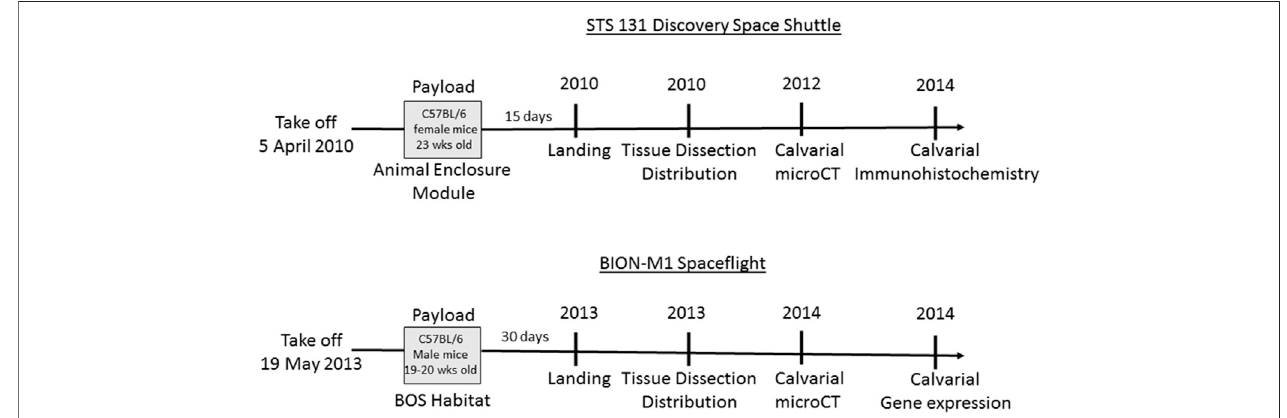
FIGURE 1 | Schematic of the timeline for STS-131 and BION-M1 missions and associated design of space fl ight experiments. The Discovery vehicle launched for STS-131 on 5 April 2010 carrying 23 week-old C57BL/6 female mice. At the conclusion of a 15-day orbital fl ight, Discovery landed and experimental subjects were collected. Following euthanization, mouse tissue was dissected and distributed to participating laboratories. We received the mouse calvaria and performed µCT and immunohistochemistry analysis on the calvaria. Next, 19 – 20 week-old male mice were aboard the BION-M1 space fl ight for 30 days before landing, tissue dissection and distribution. The mouse calvaria were transported in RNA later to our lab for µCT, histochemistry, and gene expression